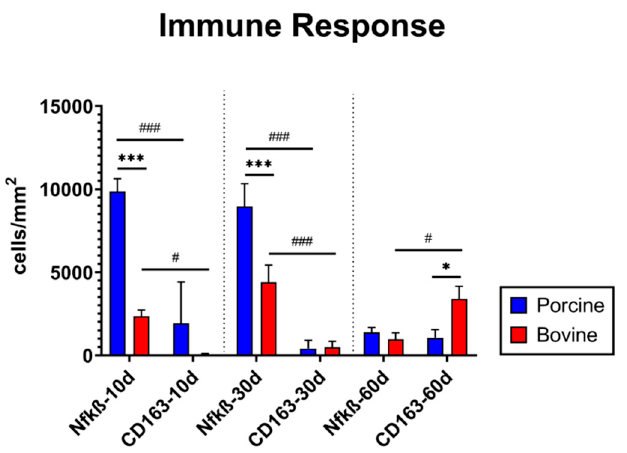
Figure 5. Results of the histomorphometrical analysis of the immune response within the implan- tation beds of both materials (*/# p ≤ 0.05, ***/### p ≤